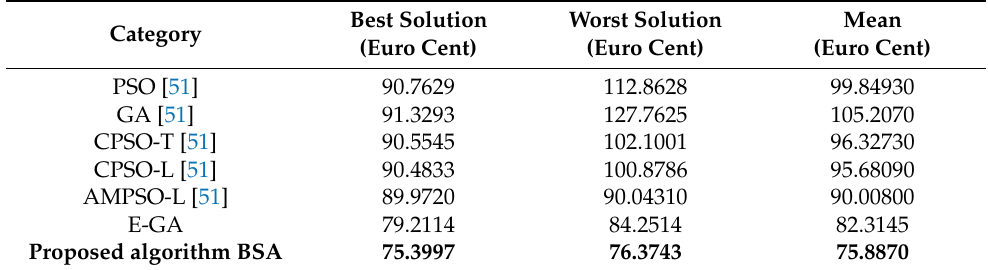
Table 7. Comparison of the cost of generation for various algorithms corresponding to Scenario 2.